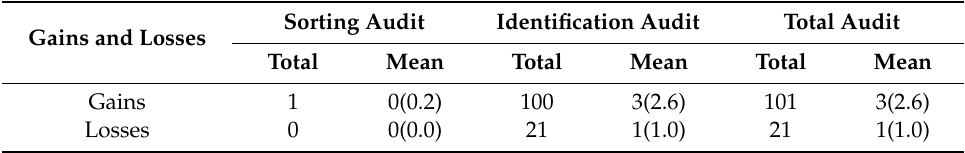
Table 3. Gains and losses (totals and means per sample) for the three audits (sorting, identification, and total). A total of 36 samples were audited. Standard deviations appear inside